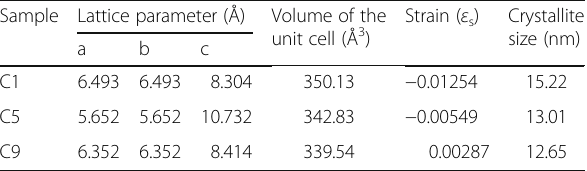
Table 1 Lattice constants, strain, and crystallite size of nanopowders Sample Lattice parameter (Å)